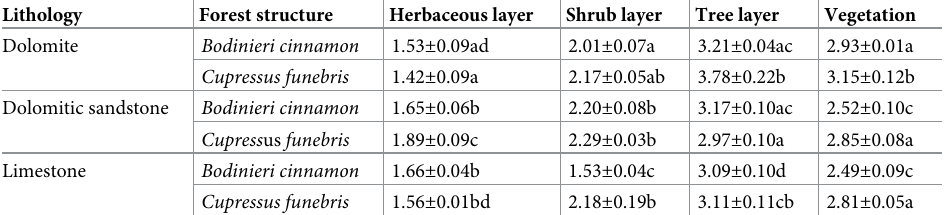
Table 4. Ratio of aboveground biomass to belowground biomass of the two plantation species under different lithologies.